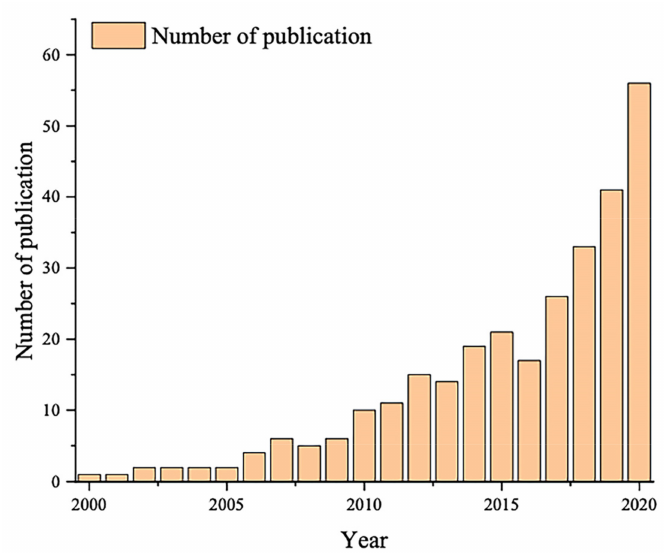
Figure 1. Publications output,